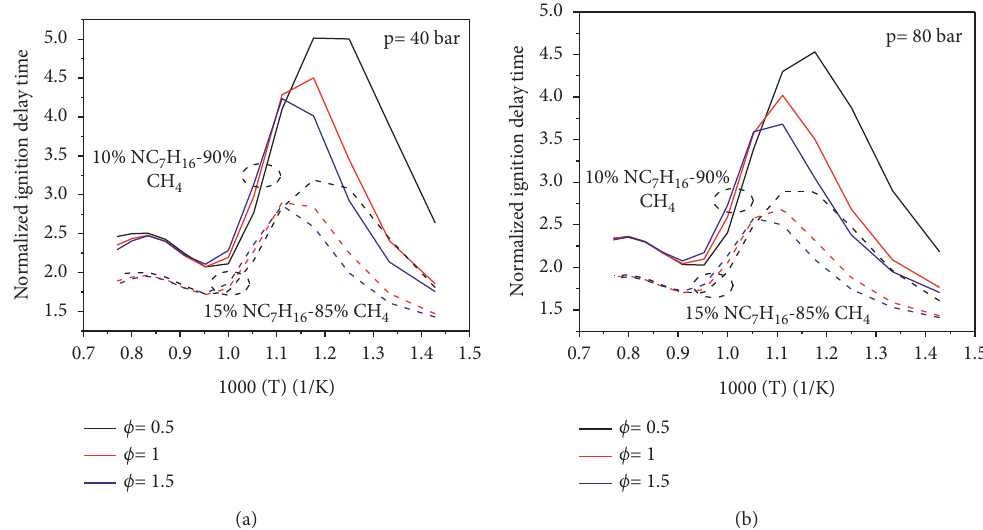
Figure 4: Normalized ignition delay of different methane/n-heptane mixing ratios at p � 40 bar, 80 bar, and different equivalence ratios.